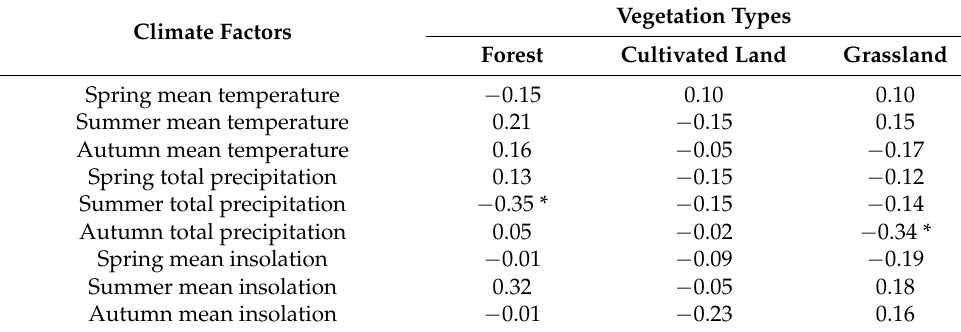
Spring mean insolation Summer mean